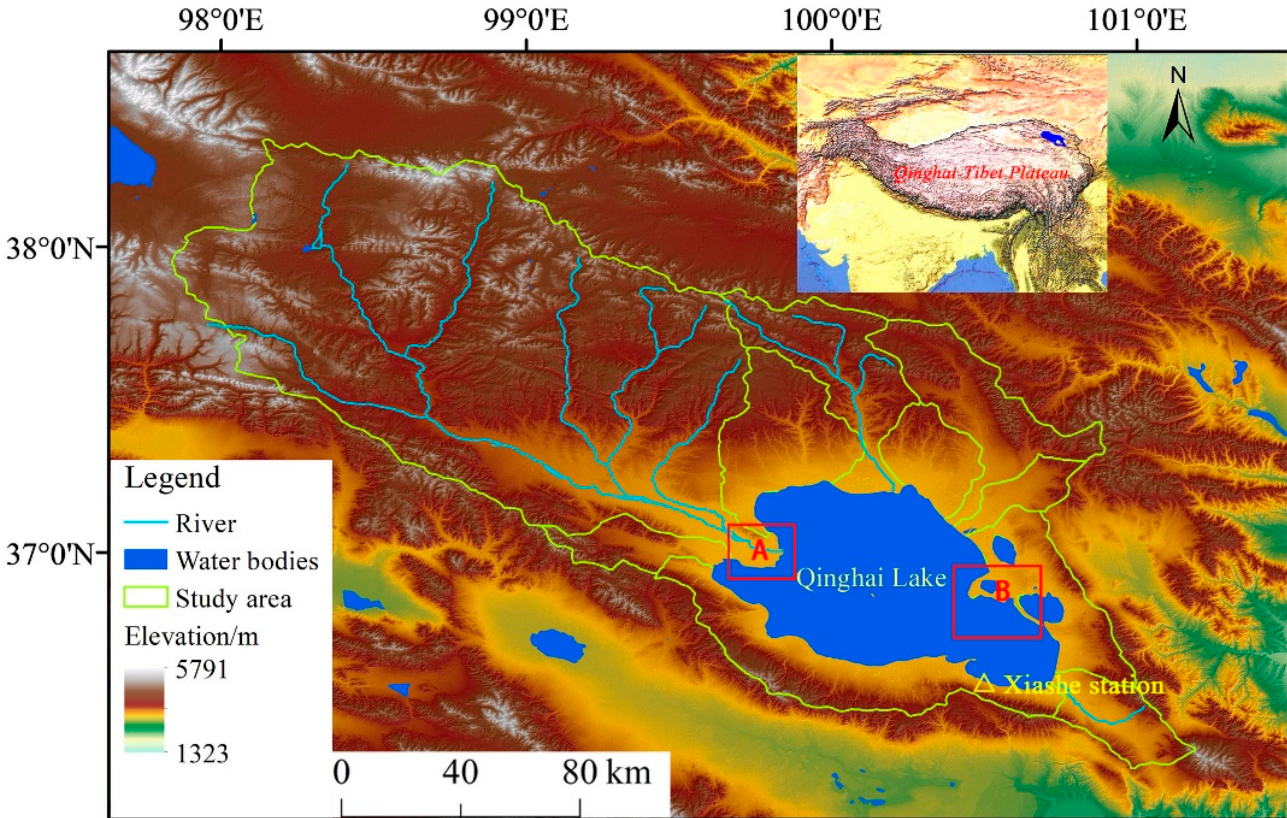
Figure 1. Map and location of the QHL. Red Rectangle A represents Bird Island on the west coast, while Red Rectangle B covers Shadao Island and Haiyan Bay on the east coast of the QHL. Yellow triangle is the Xiashe hydrological station. Blue area in the sub-figure (upper right) represents the location of the QHL in the Qinghai-Tibet Plateau.